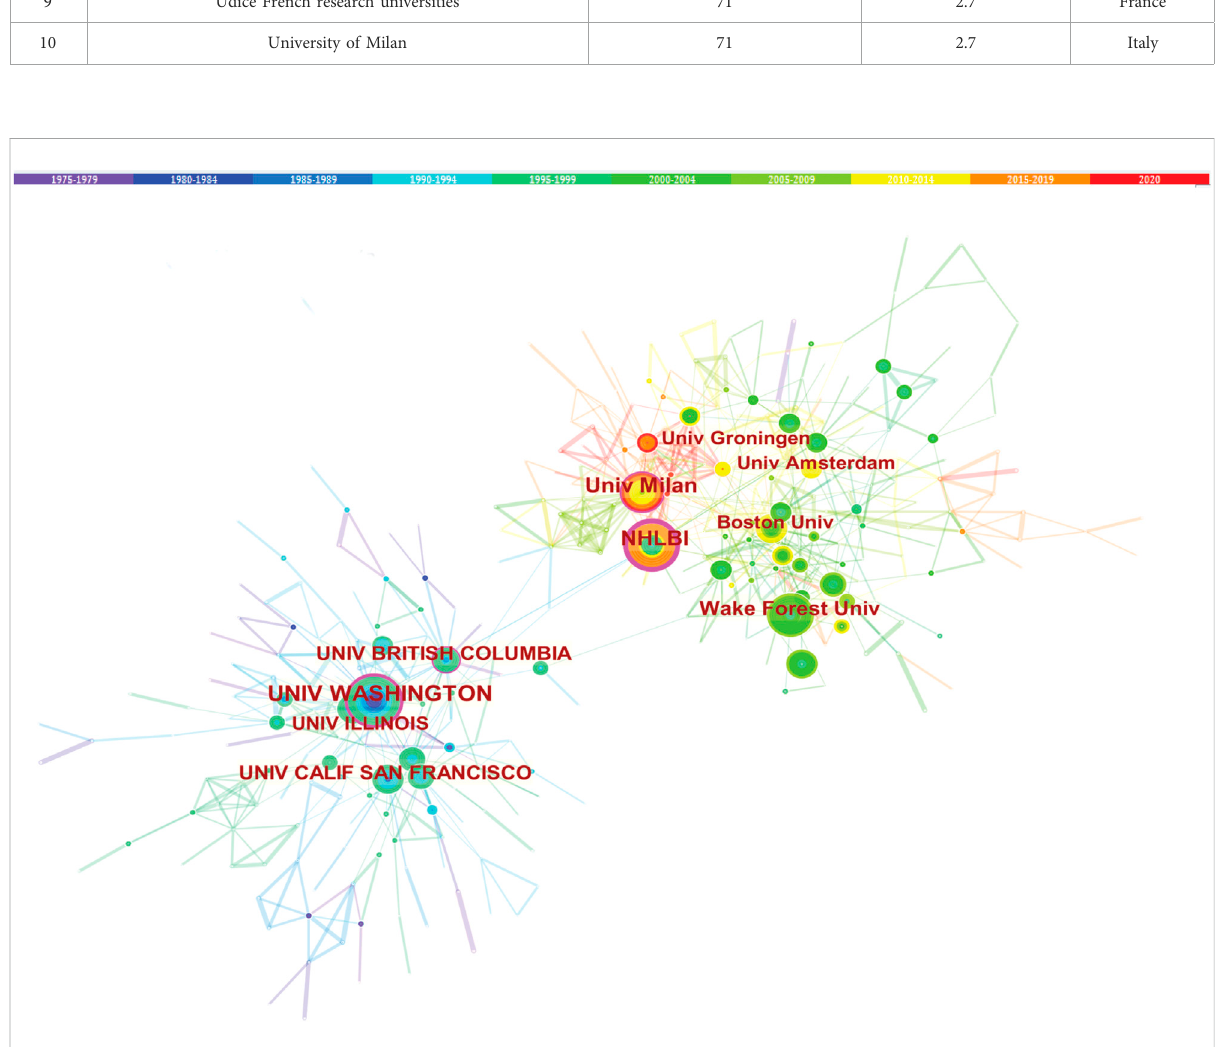
FIGURE 5 Cooperation among institutions. The co-institute network among the institutions that published the LCAT-related studies.